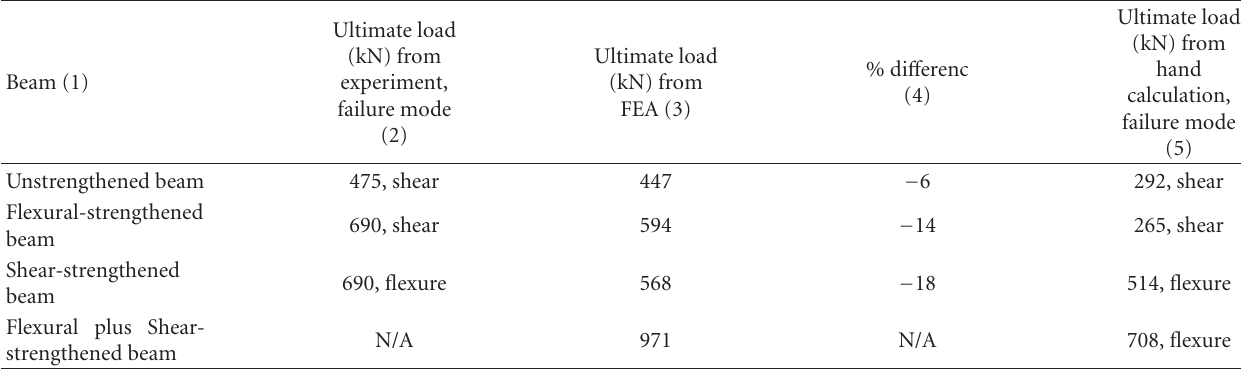
Table 3: Comparisons between Experimental and Predicted Ultimate